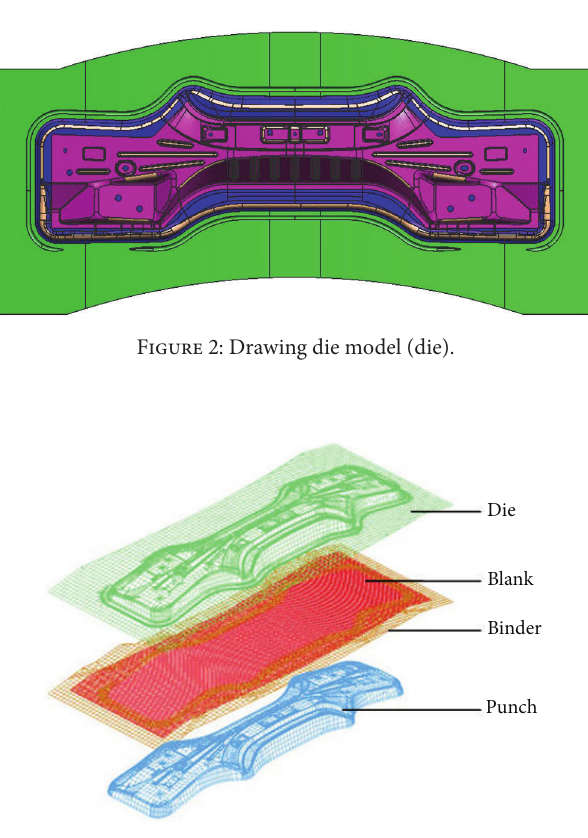
Figure 3: The FE model of automotive lower floor